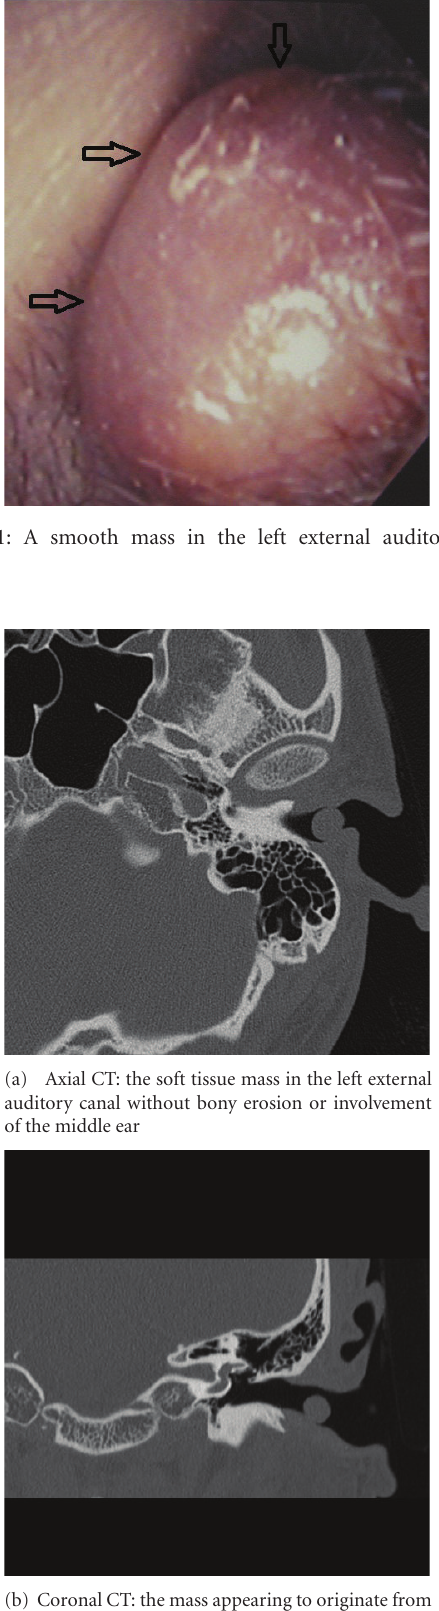
Figure 2: The CT findings.